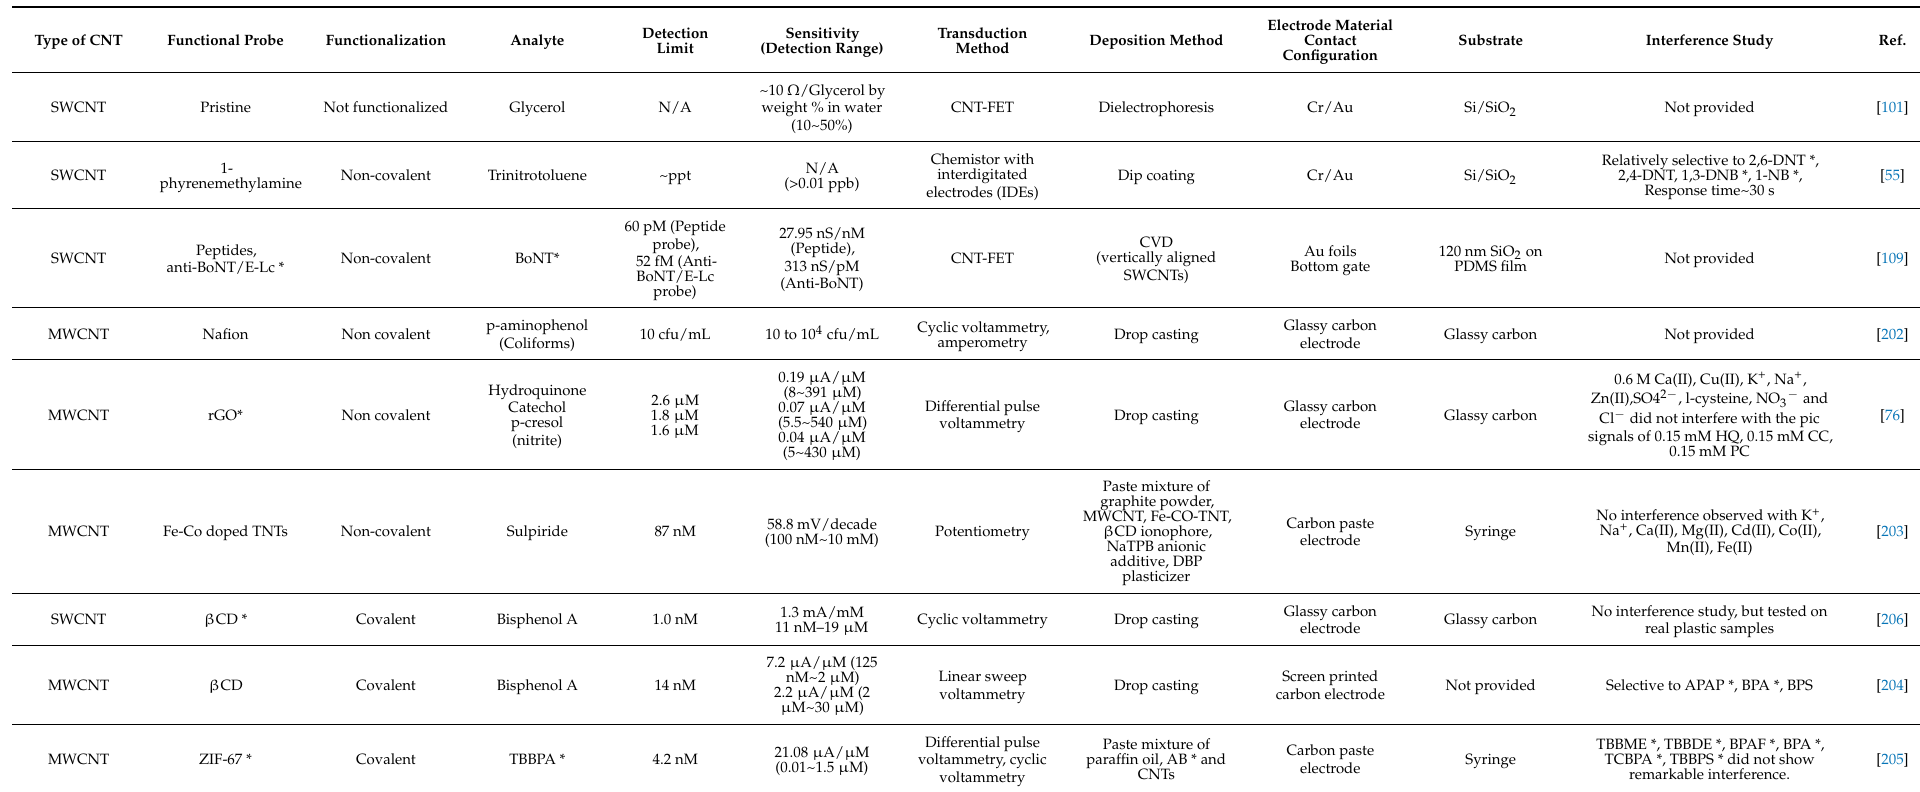
Table 16. Reported chemical CNT sensors for water quality monitoring with different probes and